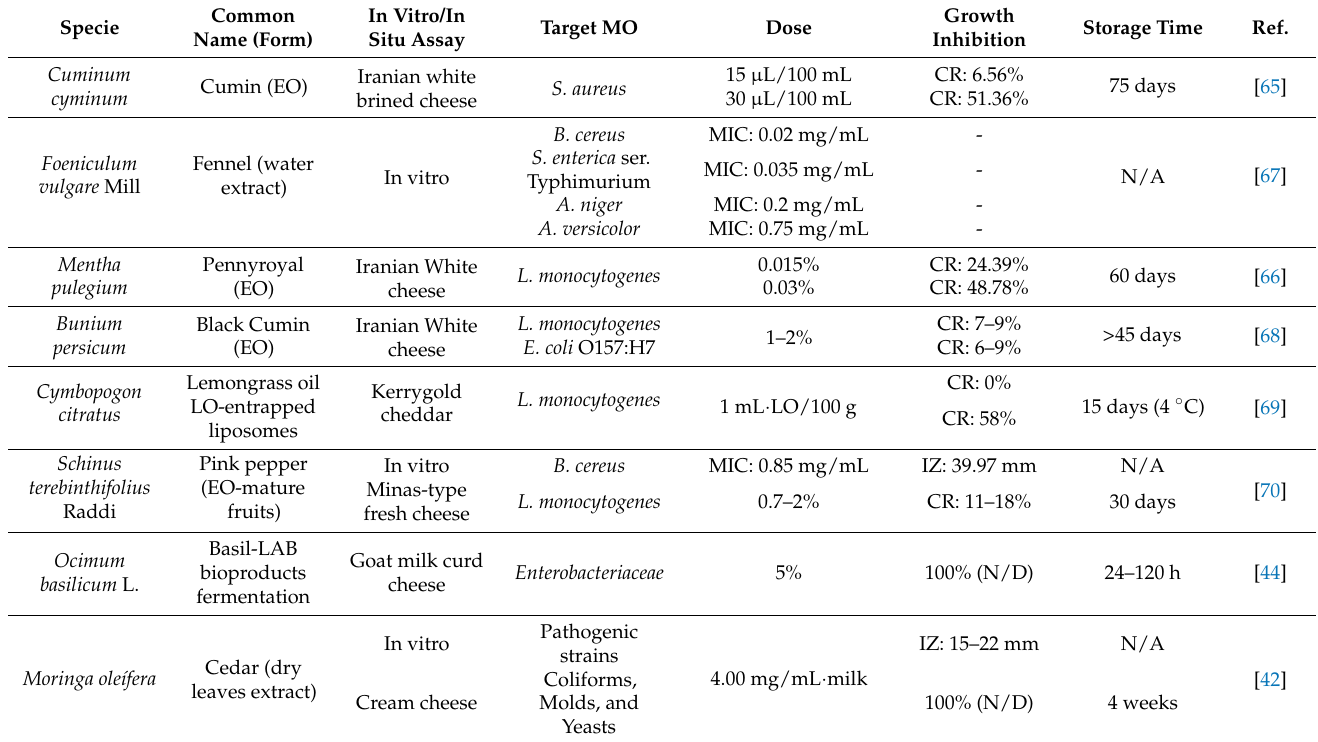
Table 2. Spices, plant extracts, or essential oils as natural antimicrobial alternatives to traditional additives for extending the shelf life of